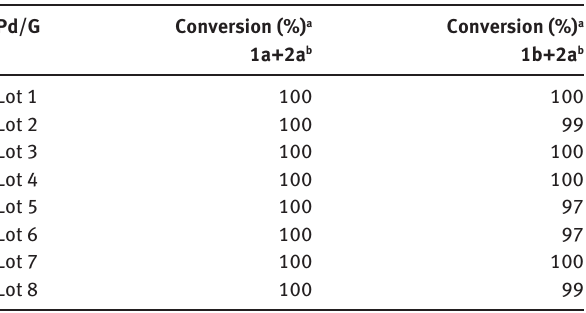
Table 1: Lot-to-lot consistency of Pd/G activity in two Suzuki- Miyaura reactions.